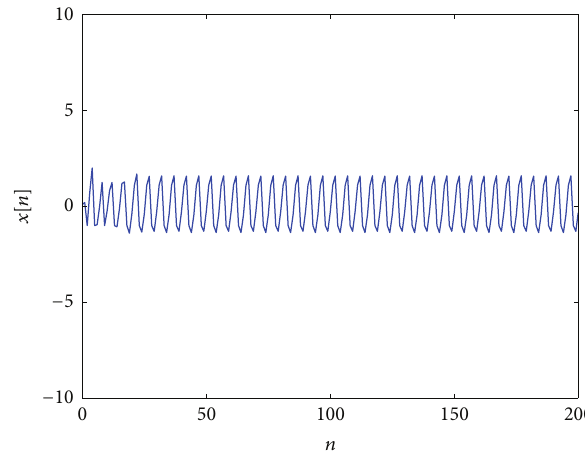
Figure 8: Eventually periodic orbit satisfies condition